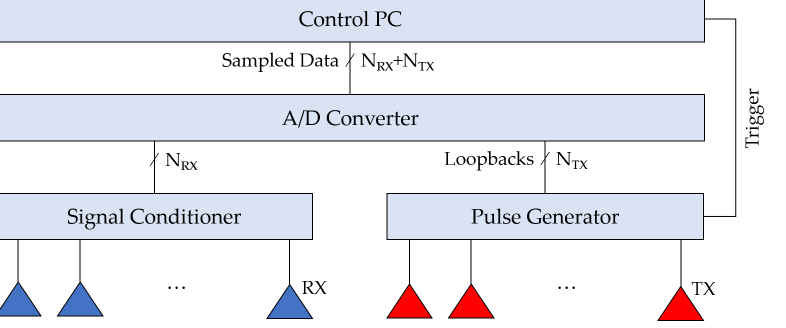
Figure 4. A block diagram of the sparse sonar data acquisition system for N RX receivers (blue) and N TX transmitters